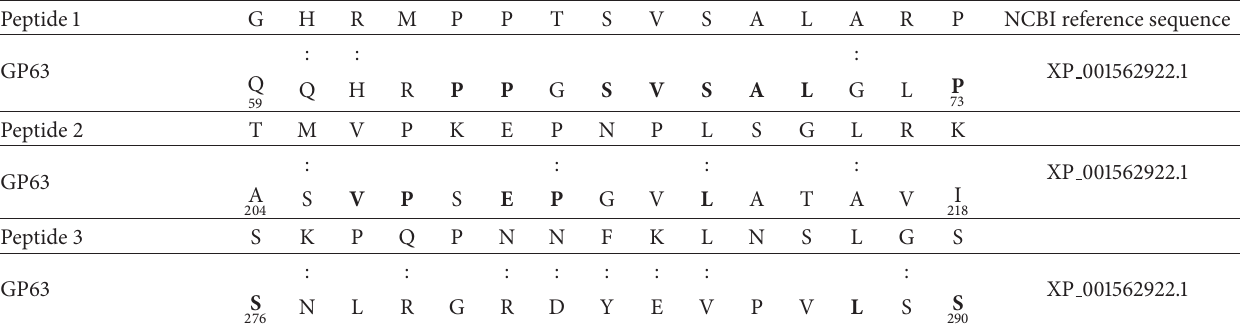
The numbering below the alignment refers to the amino acid position in the protein sequence. Bold letters denote identical amino acid residues. The colon symbol (:) indicates amino acid residues with similar properties. Among the properties that can be shared between amino acids are hydrophobicity, polarity, charge, and presence of aromatic